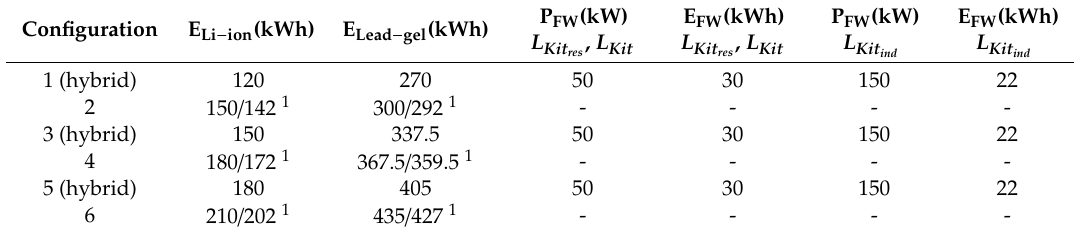
Table 3. Analyzed ESS configurations for Li-ion and Lead-gel